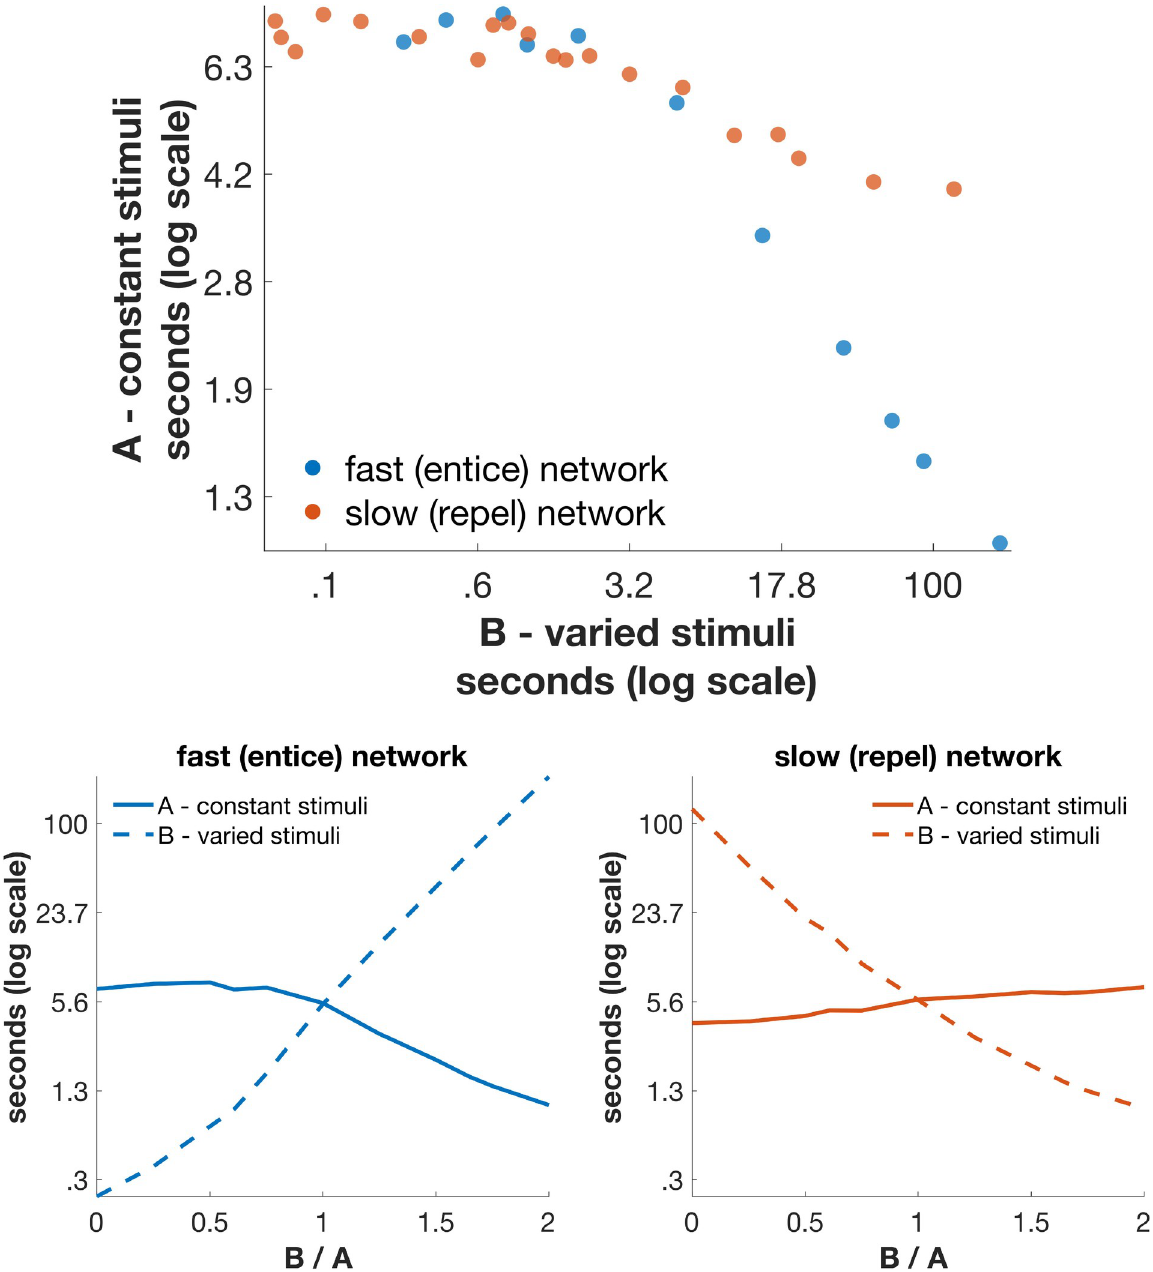
Fig 5. Mean duration of sampling bouts in simulated taste preference tests depends on the alternative stimulus in a competitive manner. (Top) Behavior of intrinsically fast-switching (“entice-to-stay”) networks is shown as blue points, and intrinsically slow-switching “repel-to- leave” networks as red points. In both networks the greater the palatability of stimulus B, the lower the perceived palatability of the unchanging stimulus A, but the bout-to-bout competition is much stronger in the “entice-to-stay” network when stimulus B is highly palatable. (Bottom) Mean durations of the “stay” state are plotted as a function of the ratio of the inputs corresponding to the two stimuli, A and B. Each pair of a values for a given ratio provides one data point in the top panel. The input for stimulus A is held fixed while the input for stimulus B is varied as a parameter to produce distinct values along the x-axis. The two classes of network are distinguished in whether the input excites the “stay” pool (entice-to-stay network, lower left) or the “leave” pool (repel-to-leave network, lower right) and whether, respectively, high input or low input for stimulus B reflects the most hedonic stimulus B. Competition is revealed as the duration of responses to stimulus A (solid line) changes in the absence of any change in inputs for stimulus A (most evident in the left panel).